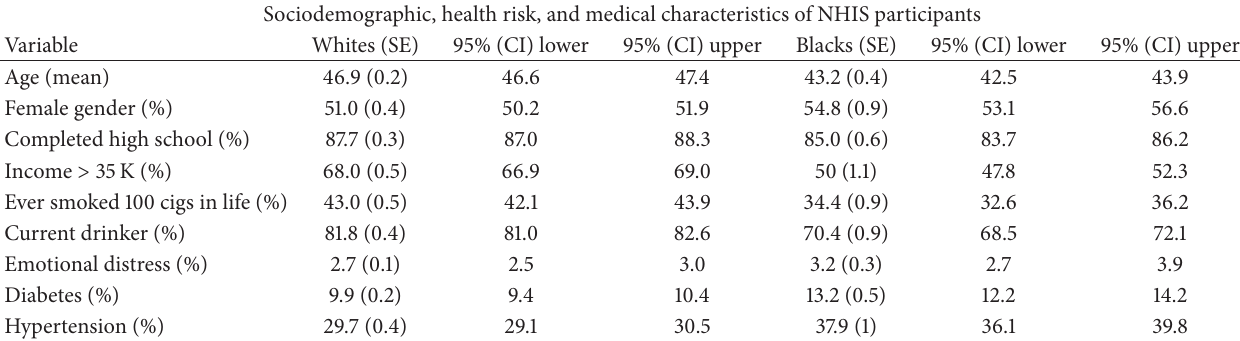
Table 1: Baseline data of participants in the 2010 National Health Interview Survey (NHIS).